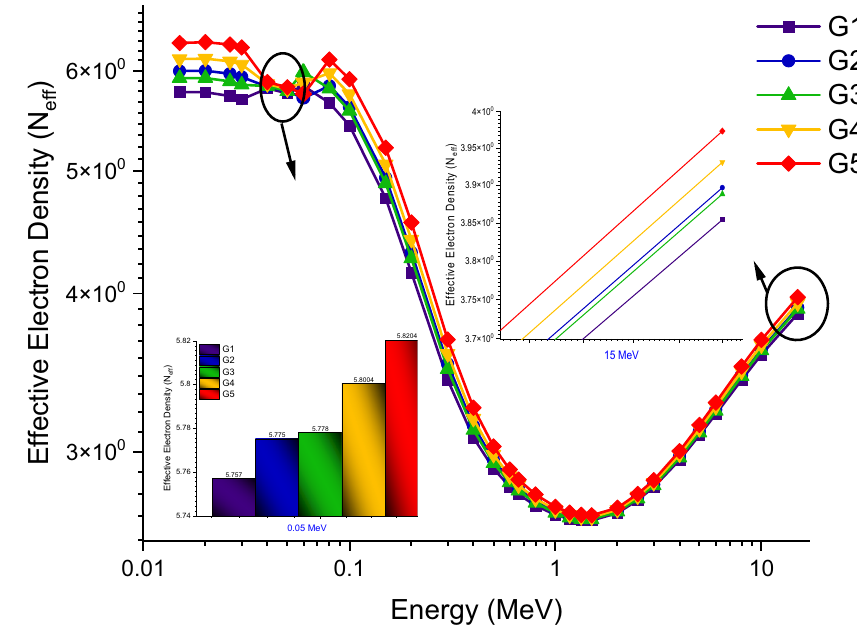
Figure 8: Variation of e ff ective conductivity ( C e ff ) with photon energy ( MeV ) for all G1 – G5 glasses.